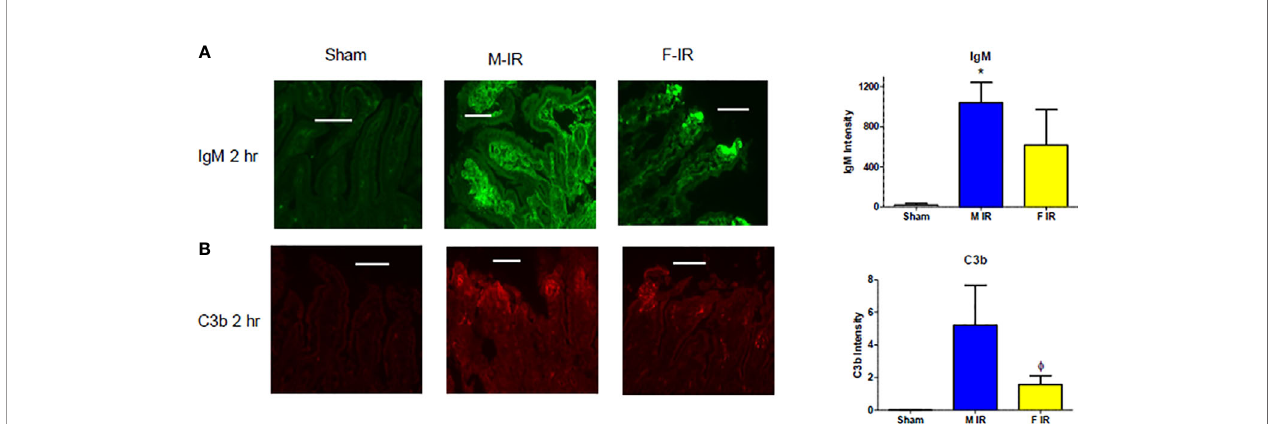
FIGURE 3 | Intestine tissue IgM, and C3b deposition after 2 h reperfusion differs between sexes. C57B6L/J mice were subjected to Sham and IR treatment with 30- or 120-min reperfusion. Intestinal sections from Sham or IR WT mice were stained for (A) IgM and (B) C3b by immunohistochemistry. Bar = 40 m m. The image analyses for each animal were determined by digital densitometry recognition using computer-aided ImageJ (NIH). Microphotographs (200X) are representative of at least 3-4 mice stained in at least 3 independent experiments. *, indicates signi fi cant difference between IR treatment and Sham within the same sex (P ≤ 0.05), as determined by 1-way ANOVA followed by Newman Keuls post-hoc test; Ф , indicates signi fi cant difference between sexes in the same time point and same treatment (P ≤ 0.05), as determined by unpaired